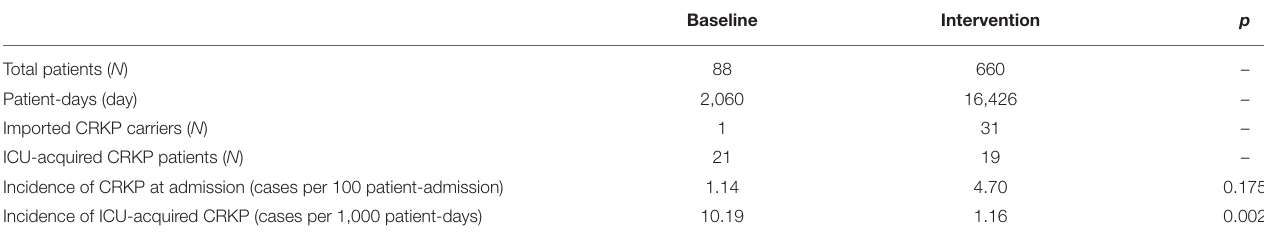
TABLE 3 | Epidemiology of patients with culture isolates identified as carbapenem-resistant Klebsiella pneumoniae (CRKP).